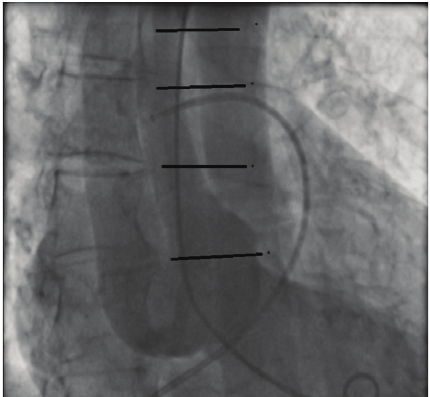
Figure 3: Dissection flap in the ascending aorta.